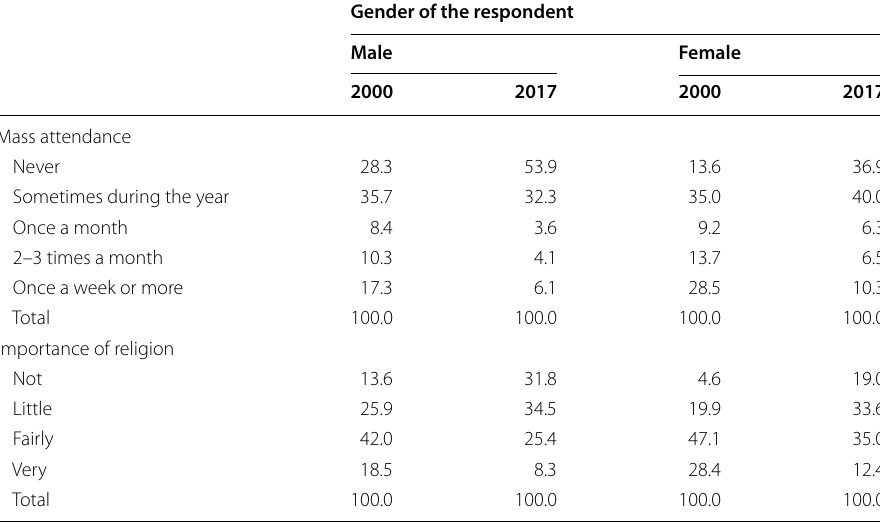
Source: authors’ elaboration on SIS and SELFY surveys